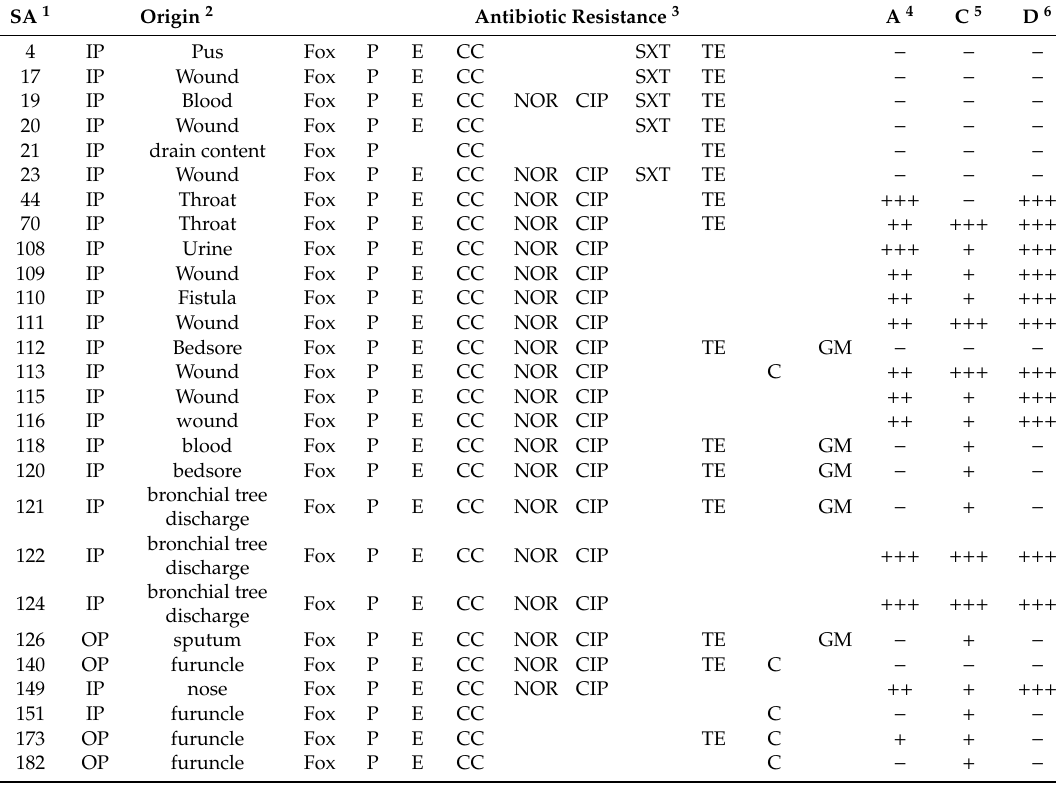
Table 3. Host range of phages vB_SauM-A, vB_SauM-C, vB_SauM-D on 67 multidrug resistant S. aureus clinical